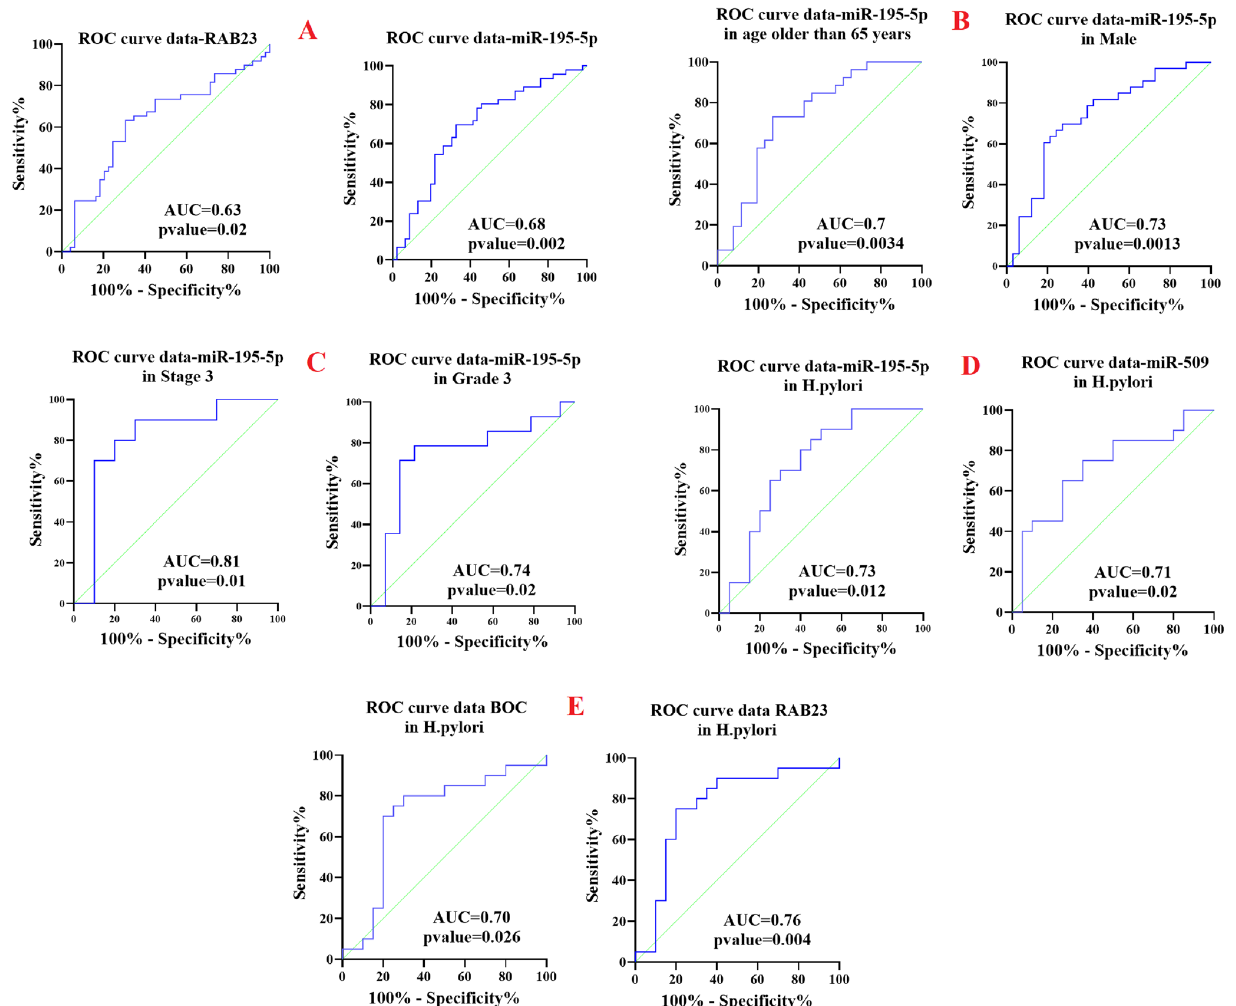
Figure 8. Receiver operating characteristics (ROC) curves for gene expression of potential biomarkers in gastric cancer. ( A ): The AUC of RAB-23 and miR-195-5p in gastric canccer was 0.63 and 0.68, respectively ( B ): The AUC of miR-195-5p in gastric cancer patients older than 65 years and male patients were 0.7 and 0.73, respectively ( C ): The AUC of miR-195-5p in advanced stage and grade in gastric cancer patients were 0.81 and 0.74, respectively ( D ): The AUC of miR-195-5p and miR-509 in H.pylori negative gastric cancer patients was 0.73 and 0.71, respectively ( E ): The AUC of BOC and RAB23 in H.pylori negative gastric cancer patients was 0.7 and 0.76, respectively. AUC: the area under the